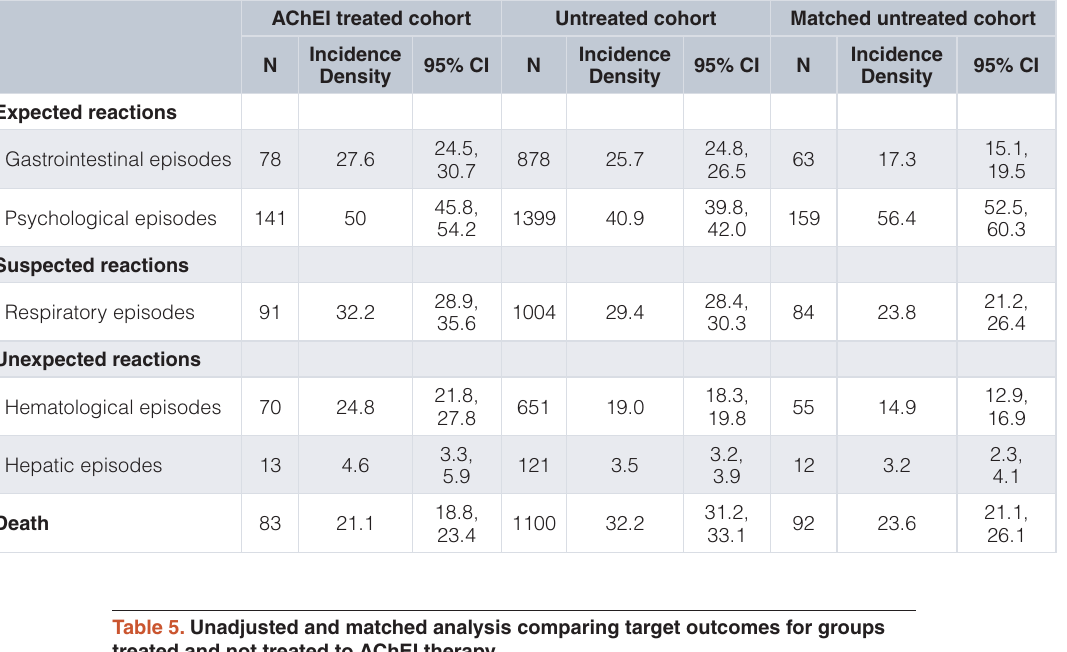
Table 5. Unadjusted and matched analysis comparing target outcomes for groups treated and not treated to AChEI therapy.